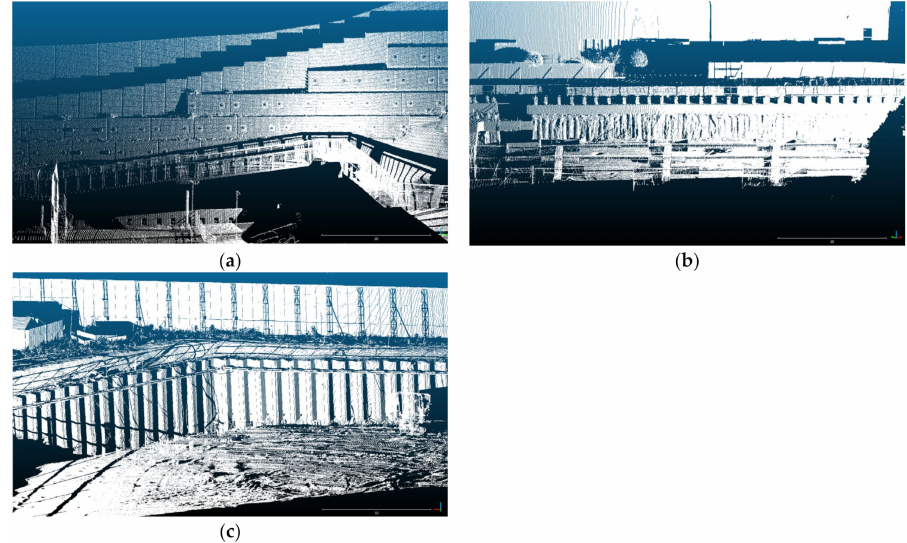
Figure 2. Point clouds of different retaining structure types, ( a ) Concrete panel ( b ) Soil mixing wall ( c ) Sheet